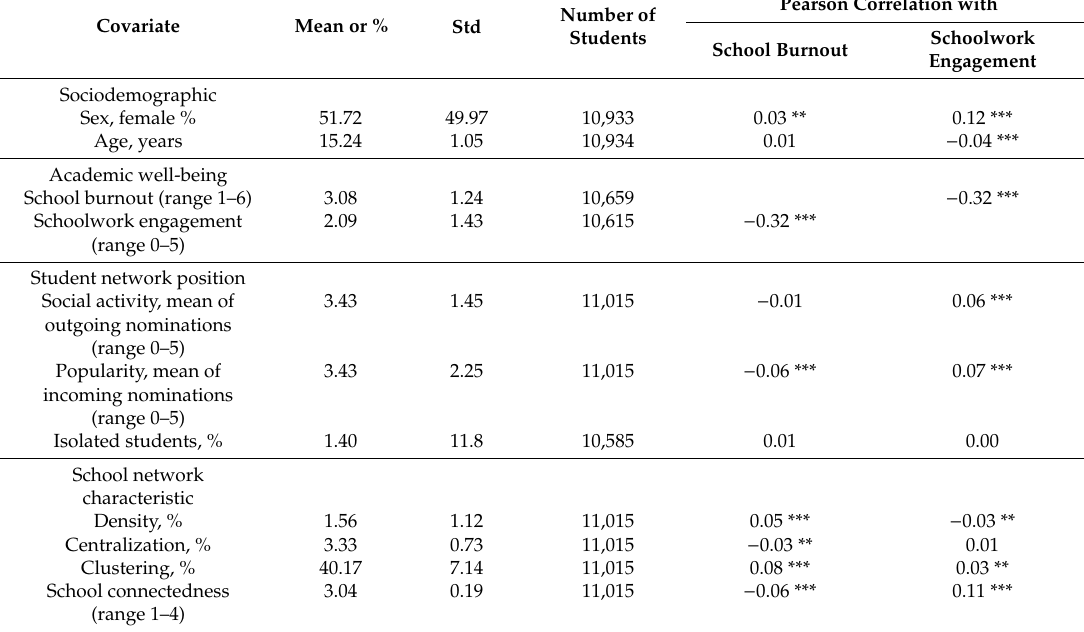
Table 1. Mean or percentage (%) and standard deviation (Std) of students’ socio-demographic and academic well-being indicators, students’ network position and school network characteristics, and their correlation with academic well-being indicators. Pearson Correlation with Number of Covariate Mean or % Std Students Schoolwork School Burnout Engagement 51.72 49.97